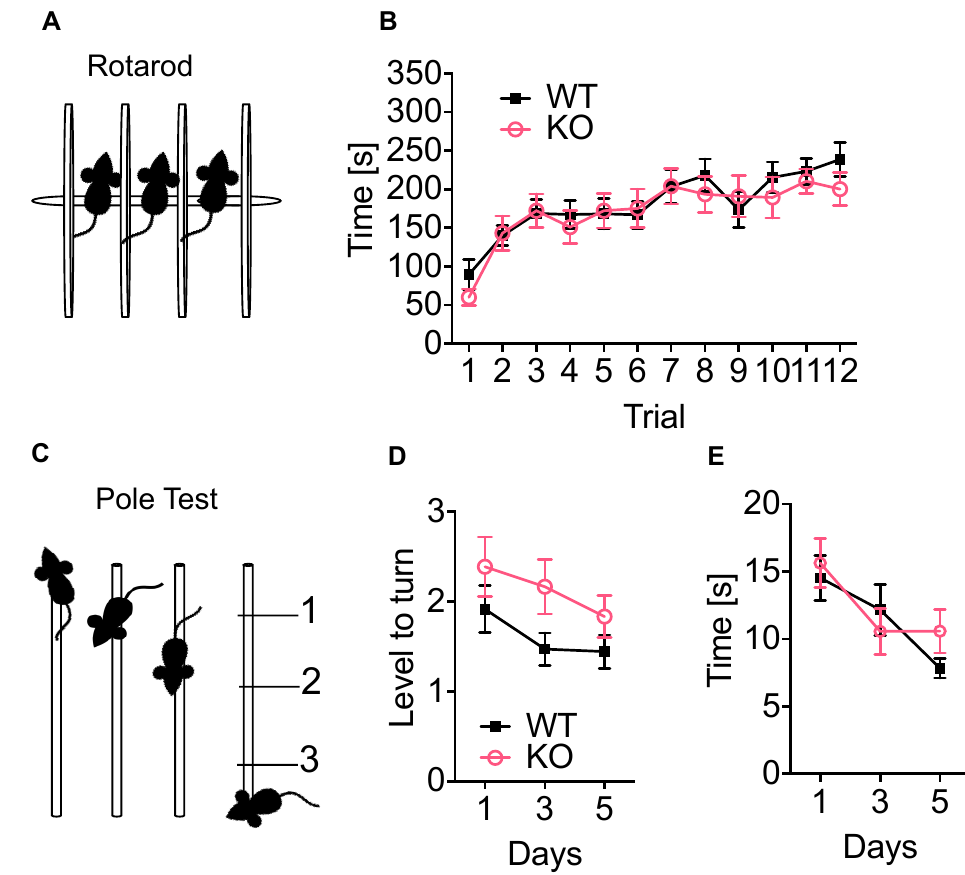
Figure 5. p62 KO mice show normal motor learning, coordination, strength, and endurance. ( A ) Rep- resentative image of the rotarod apparatus. ( B ) The time mice spent running on the rotarod was improved during training and was similar between p62 KO and WT mice. ( C ) Representative image of the pole test. ( D ) The level to turn (180 ◦ ) was improved over time and was comparable between p62 KO and their WT littermates. ( E ) The time mice needed to climb down the pole was improved over time and equally in p62 KO and WT mice. Data were analyzed by using 2-way ANOVA repeated measurements. All error bars show mean ± SEM. Age: 3–4 months old, male WT N = 12; KO N =